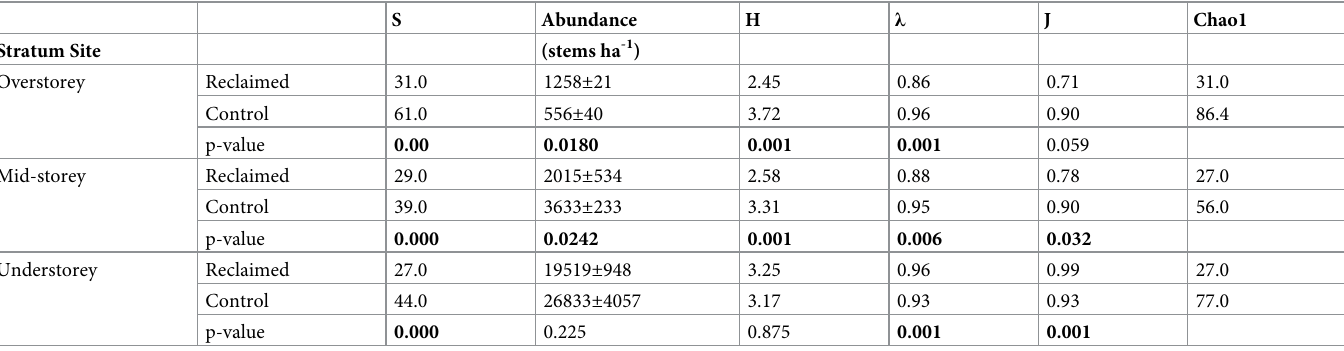
Table 1. Species diversity characteristics of the overstorey, mid-storey and understorey vegetation on reclaimed (n = 24) and adjacent natural forest (control n = 3) sites. S Abundance H